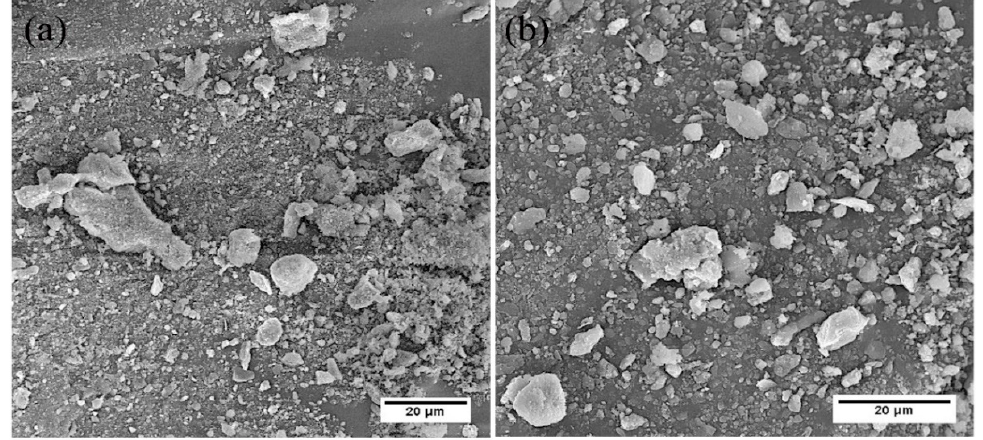
Figure 12. Micromorphology of debris after ( a ) one and ( b ) eight steps.